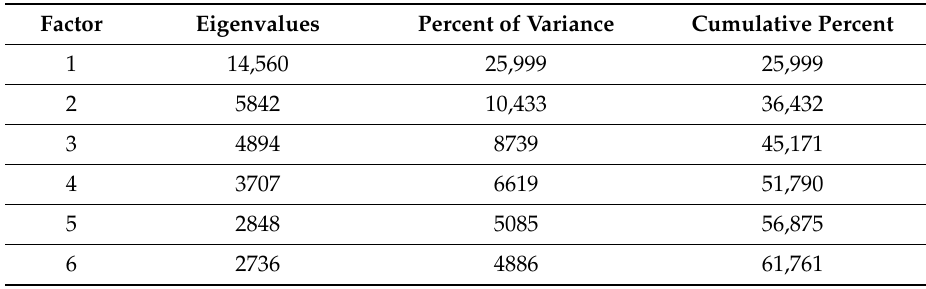
Table 3. Total Variance